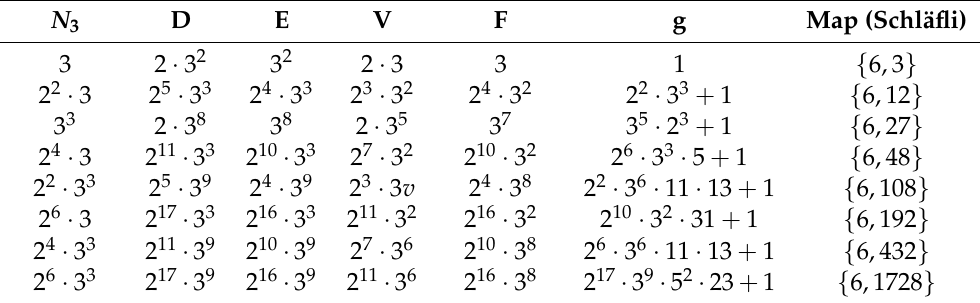
Table 3. The complete table of regular maps for N 3